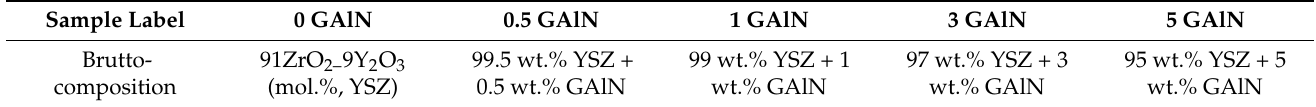
Table 1. Obtained YSZ-GAlN samples labelling, their brutto compositions and used sintering conditions. Sample Label 0 GAlN 0.5